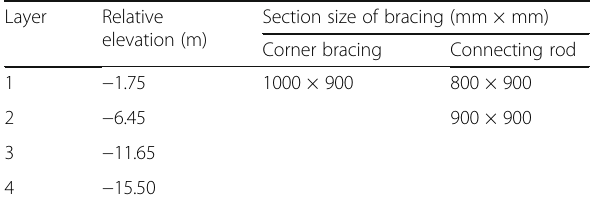
Table 3 Parameters of concrete